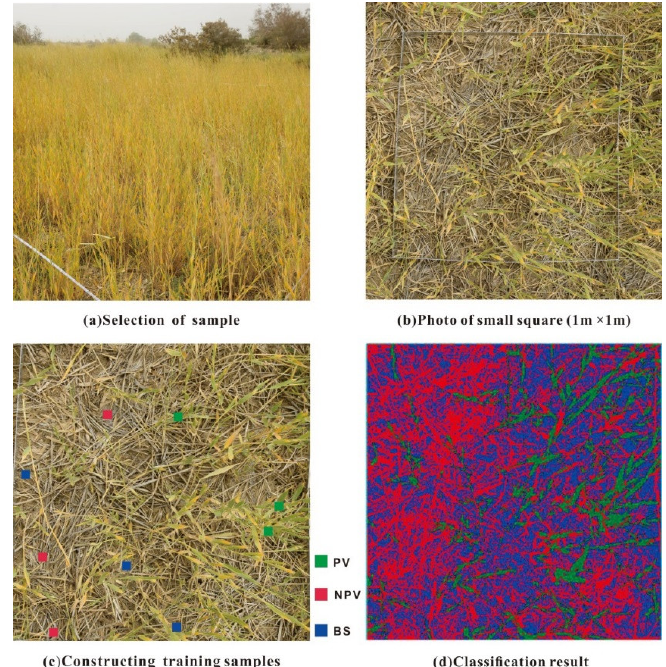
Figure 2. Field square acquisition and classification processing.